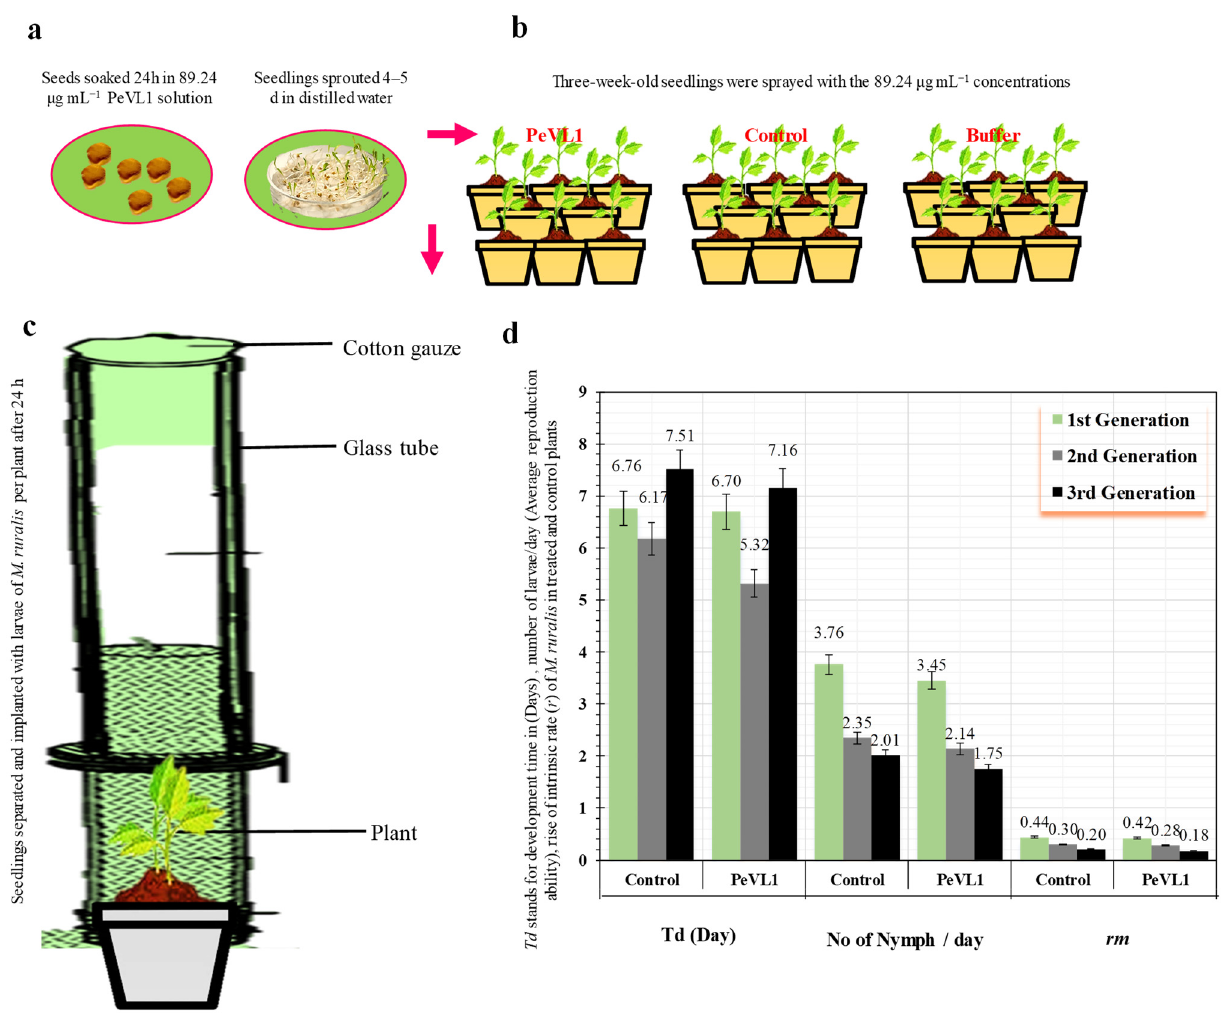
Figure 2. Marasmia ruralis development time in O. sativa seedlings treated with PeVL1 and control, ( a , b ) Seeds and seedling treatment (Mean ± SD), ( c ) seedlings treated with PeVL1 and control in glass tube ( d ) Seedlings treated with PeVL1 saw a substantial change of generation in M. ruralis population (mean ± SD) the study used SPSS 18.0 using LSD and one-way ANOVA at p = 0.05.